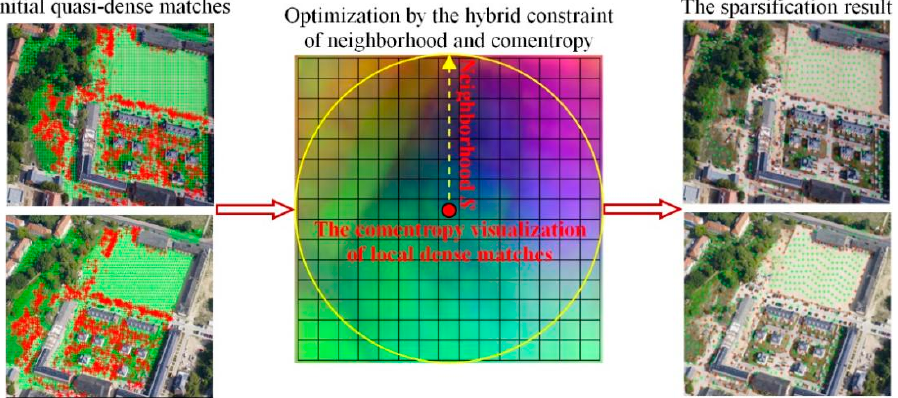
Figure 5. Illustration of the optimal selection of uniform matching points.